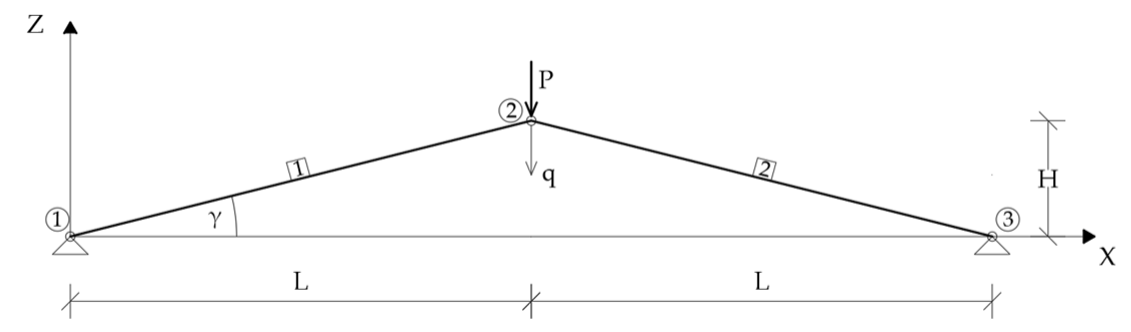
Figure 6. Von Mises truss geometry.